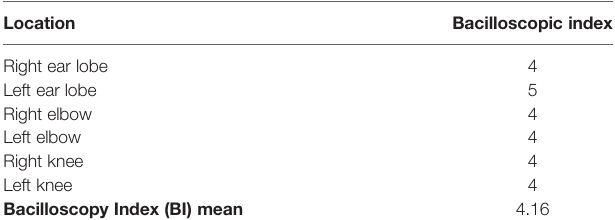
TABLE 3 | Bacilloscopic